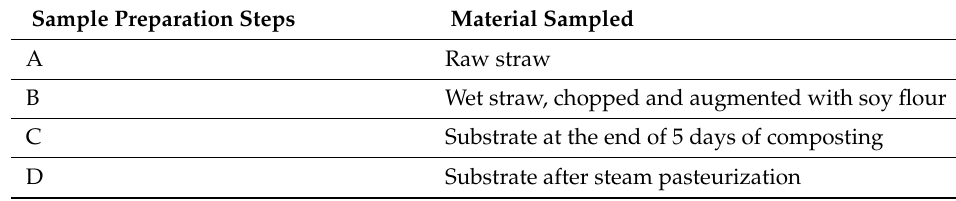
Table 2. Production cycles studied.